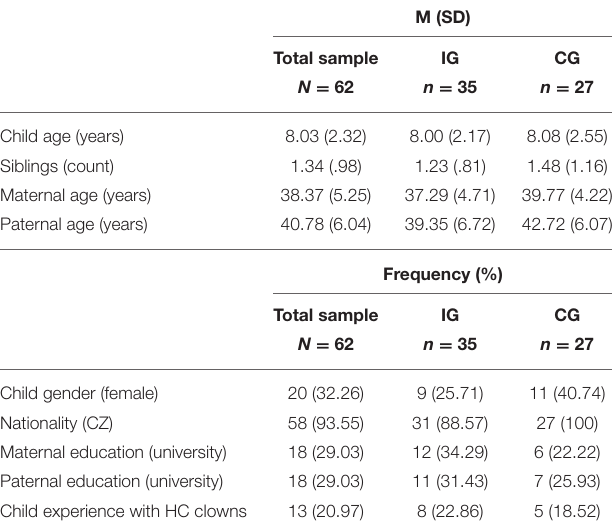
TABLE 1 | Descriptive statistics for the background characteristics of the tested sample.